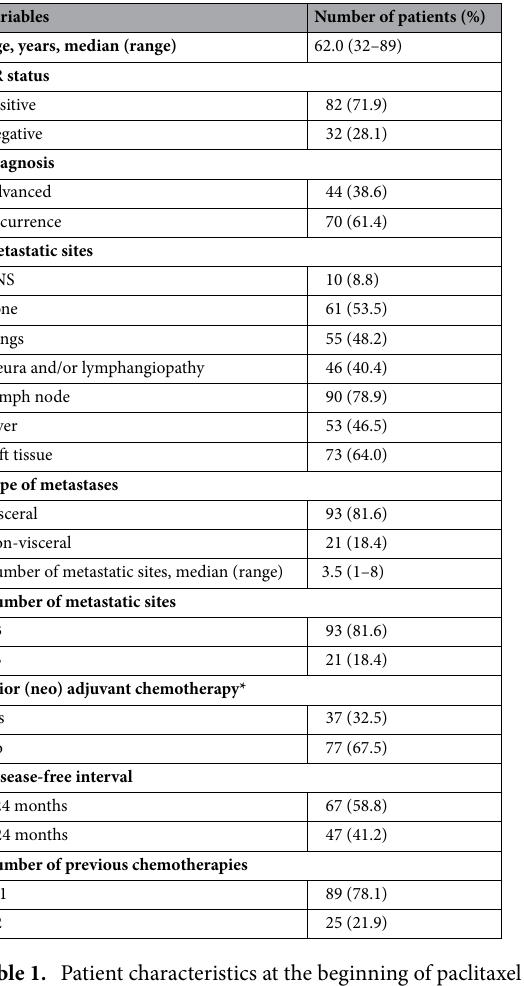
Table 1. Patient characteristics at the beginning of paclitaxel plus bevacizumab therapy. CNS central nervous system, ER estrogen receptor. *Chemotherapy included anthracycline and/or